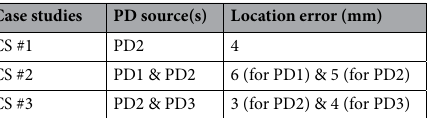
Table 1. List of the case studies considered in the paper and the resulting location